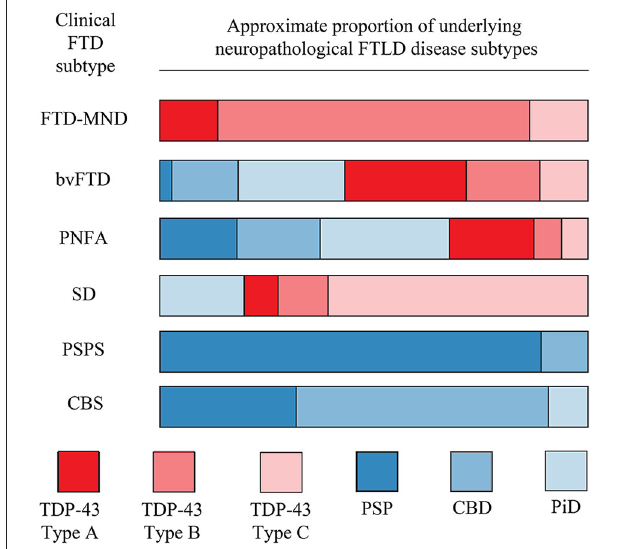
FIGURE 2 | Relationship between clinical FTD phenotype and underlying FTLD disease neuropathology . For each clinical subtype on the left, the bar is divided to show the approximate proportion of cases which are underpinned by the indicated disease neuropathology. Profound neuropathological heterogeneity exists for many clinical subtypes, particularly bvFTD and PNFA. This figure is based on data from Josephs et al.